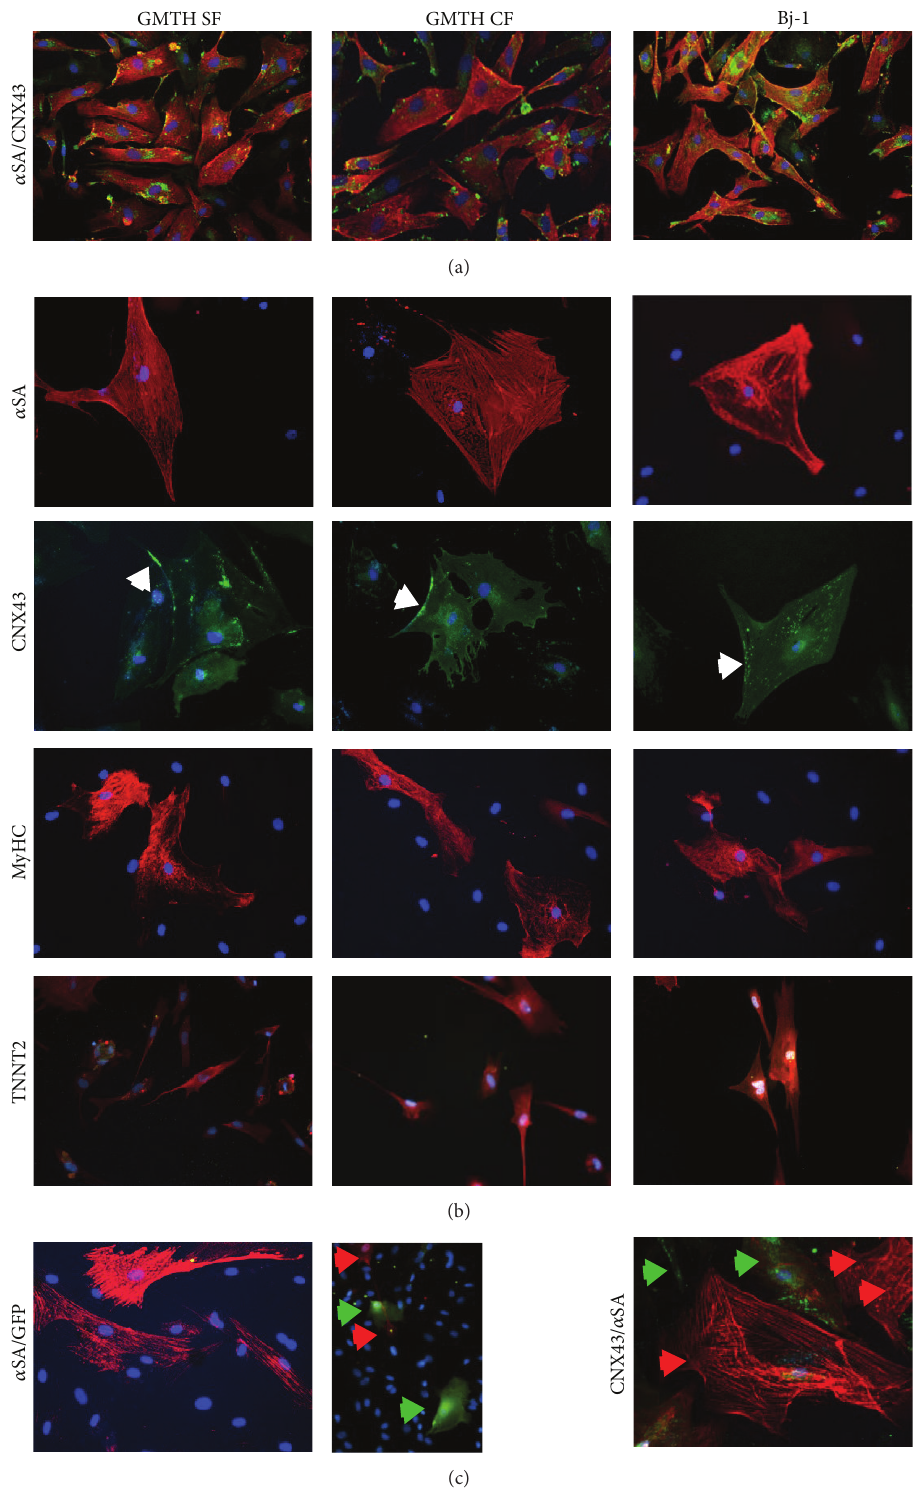
Figure 5: Localization of cardiac markers in ciCLMs. (a) Alpha sarcomeric actinin (red) and connexin 43 (green) were present in ciCLMs in similar amount to reprogrammed Bj-cells. (b) Immunofluorescence analysis revealed the expression of alpha sarcomeric actinin ( 𝛼 SA, red), connexin 43 (CNX43, green; white arrows indicate CNX43 expression on the cell membrane), myosin heavy chain (MyHC, red), and cardiac troponin T (red) in ciCLMs after 14 days under differentiating conditions. (c) ciCLM cells did not express cardiac markers homogenously. A few cells expressing 𝛼 SA were GFP negative and vice versa (left panels) and occasionally CNX43 (green arrows) and 𝛼 SA (red arrows) were mutually exclusively expressed (right